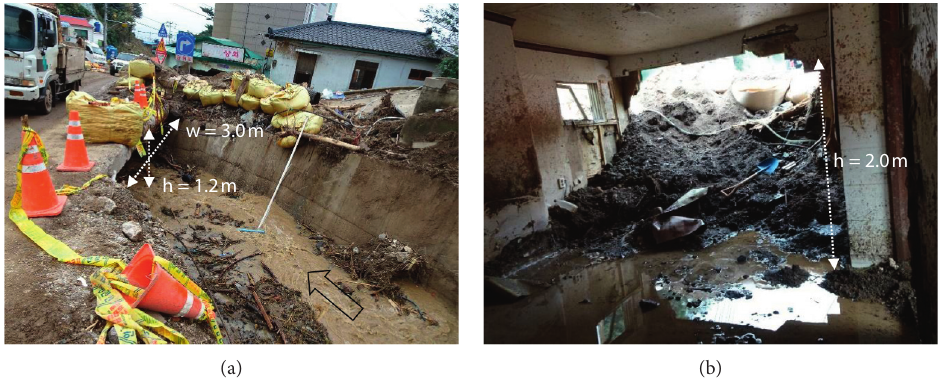
Figure 9: Images of damaged road and house with the overflow of debris flow at the covered stream section: (a) collapse of the opening, which is the starting point of the stream section covered with a road; (b) destroyed house caused by debris